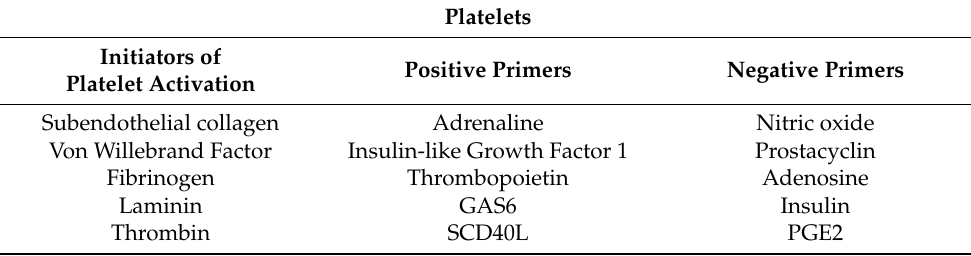
Table 1. A summary of initiators of platelet activation and platelet